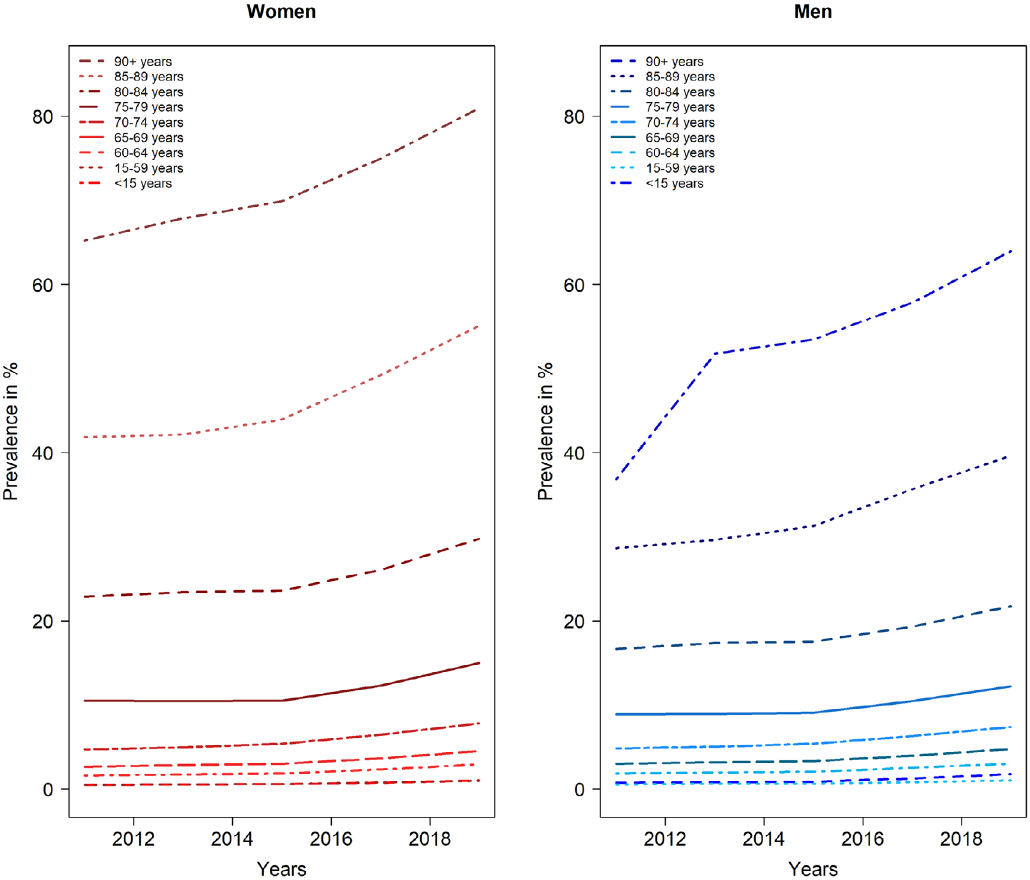
Figure1.Linechartfortheprevalence(in%)oftheneedforlong-termcarefrom2011to2019;stratifiedbysex. Representation of the age groups from <15, 15-59, from 60 in 5-year intervals up to 90+ (Data basis: care statistics from the Federal Statistical Office for the years 2011-2019).